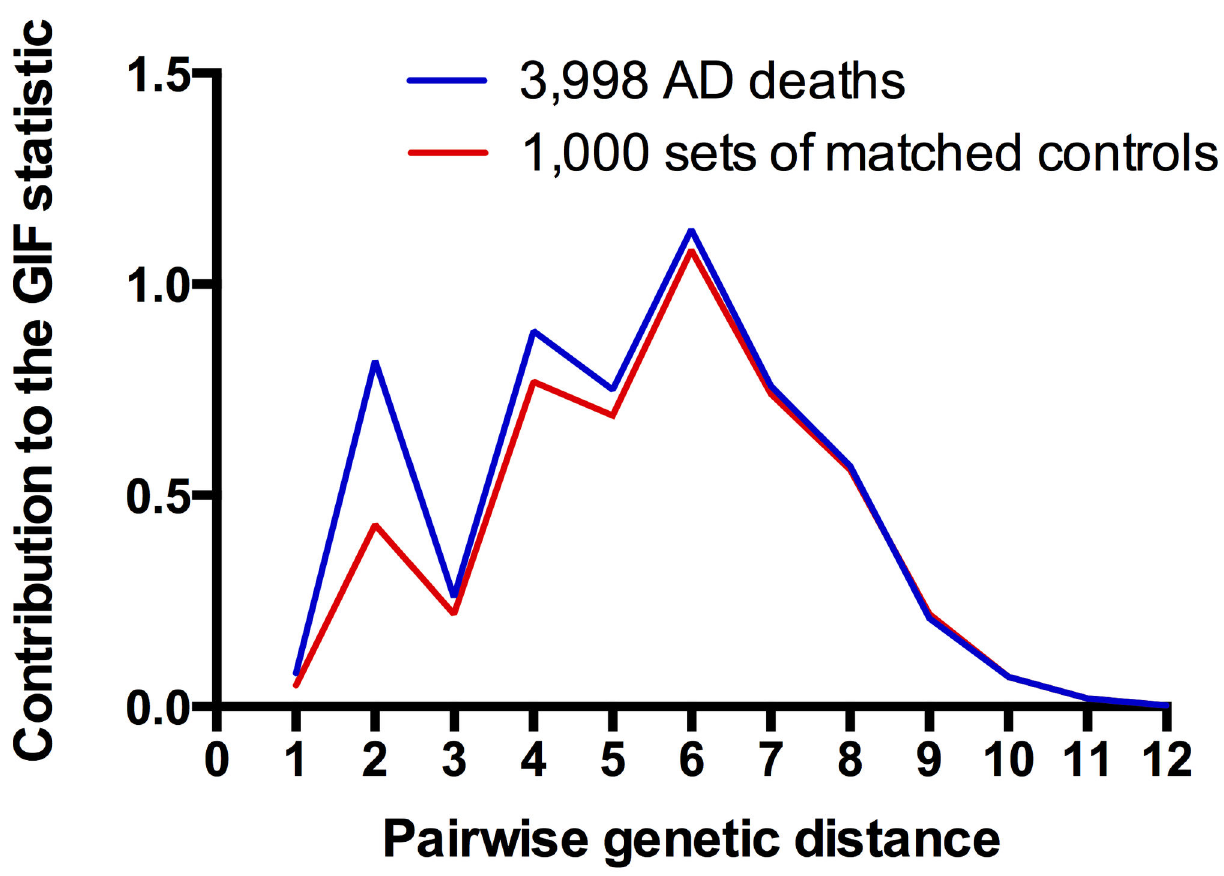
Figure 1. Contribution to the GIF statistic for Alzheimer’s disease mortality relatedness by pairwise genetic distance for cases and